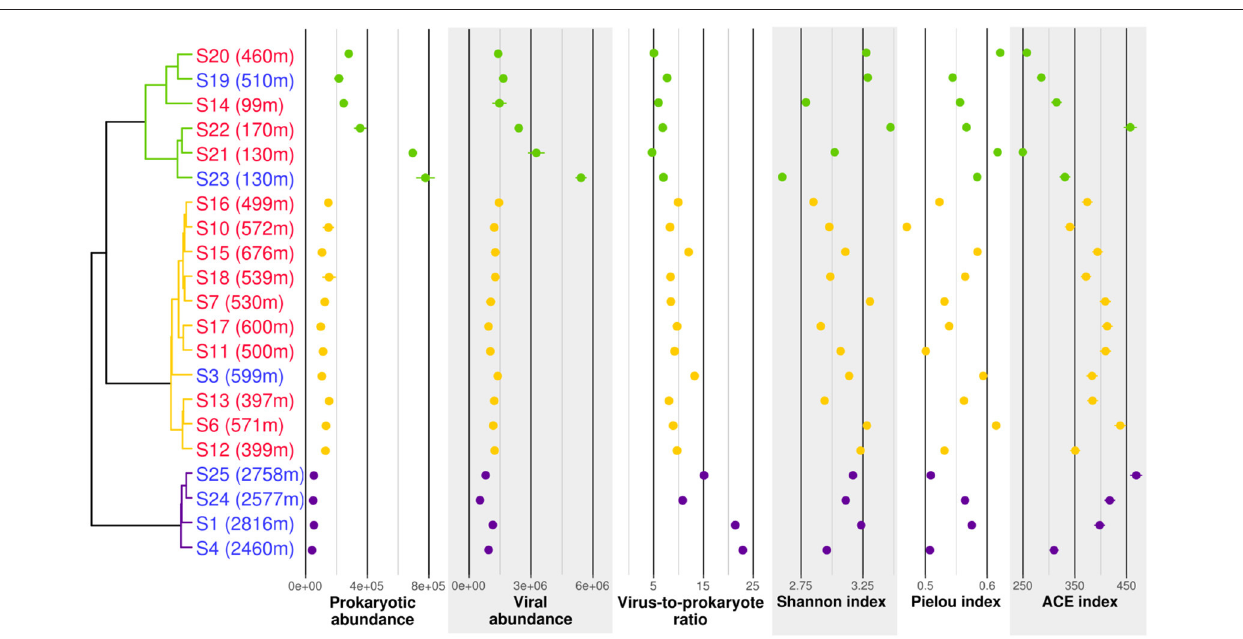
FIGURE 2 | Cluster analysis, counts and biodiversity indices of the samples used for 16S rRNA profiling. The dendrogram is based on Bray-Curtis dissimilarities of 16S rRNA OTU distributions. Samples written in red were taken in plumes while samples written in blue were taken in background water with no chemical signs of hydrothermal fluid input. Abundances are given in counts per milliliter. Purple, group P1; orange, group P2; green, group